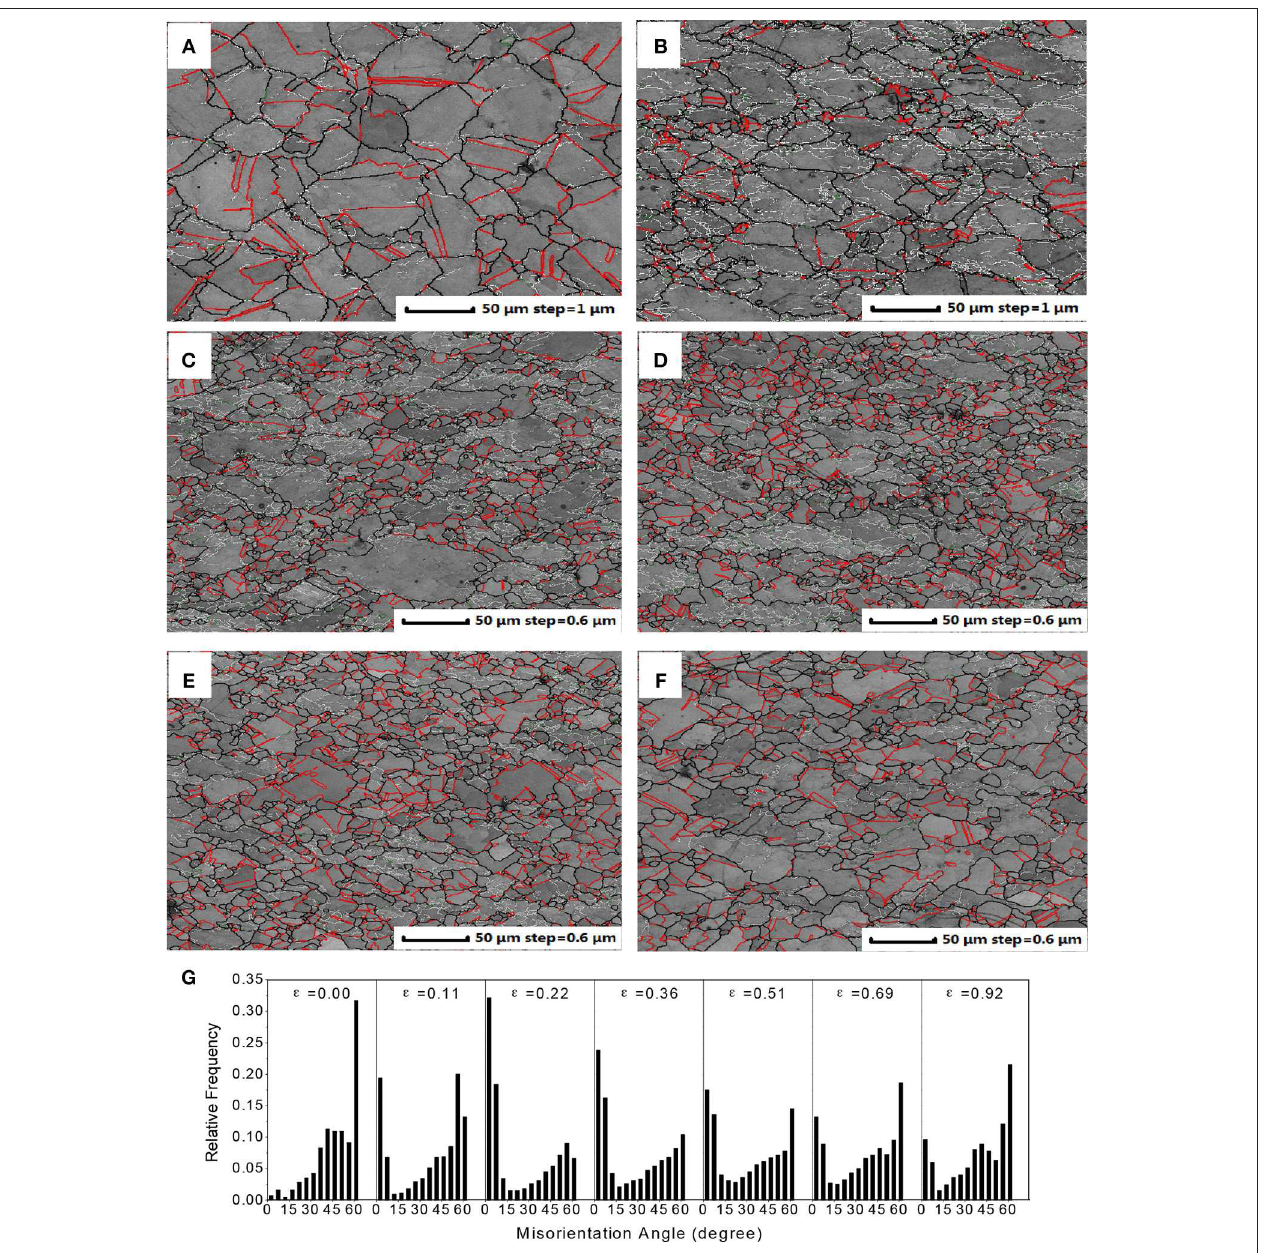
FIGURE 6 | The OIM band contrast maps for deformed samples at strain of 0.11 (A) , 0.22 (B) , 0.36 (C) , 0.51 (D) , 0.69 (E) , and 0.92 (F) . Their misorientation distribution histograms containing grain boundaries with different orientations are also displayed (G) . In OIM maps, the high and low angle boundaries are shown as black and white lines, respectively. 6 3 twin boundaries are shown as red